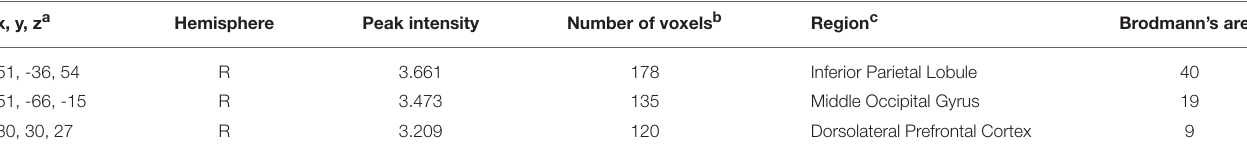
TABLE 2 | Regional brain activation for the contrast of ((IGD Substance-related words - IGD Neutral words) - (HC Substance-related words - HC Neutral words)). x, y, z